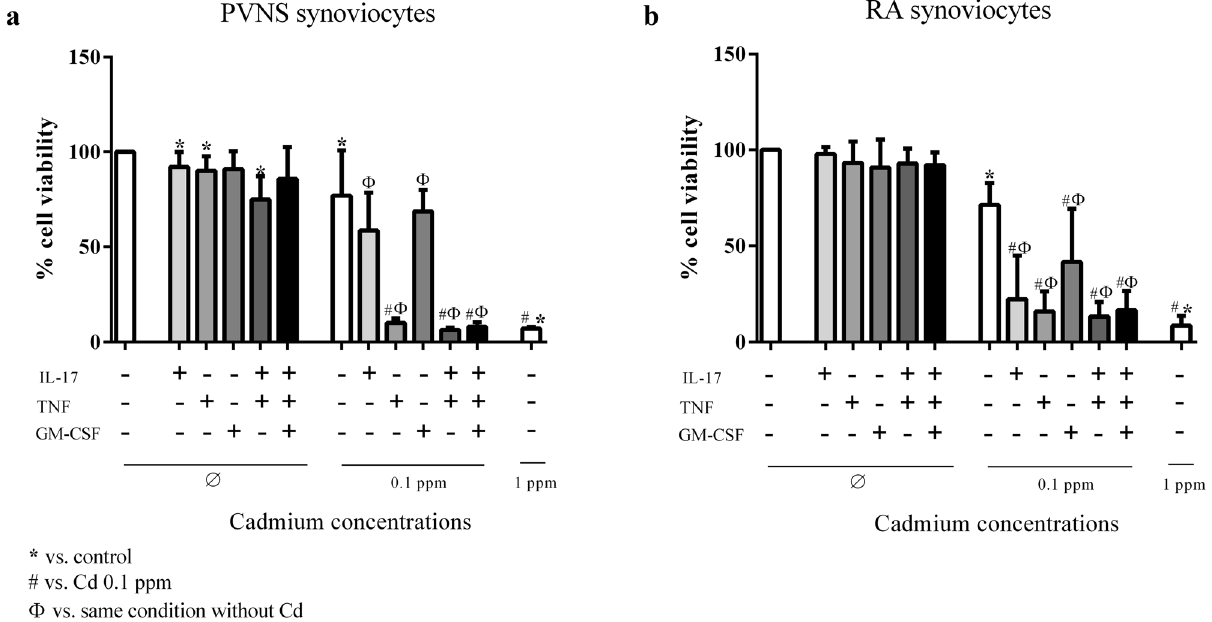
Figure 5. Quantification of cell viability of PVNS and RA synoviocytes 6 days after Cd exposure. PVNS ( a ) and RA ( b ) synoviocytes, used between passages 4 to 9, were treated or not with 0.01 ppm of Cd, in the presence or the absence of pro-inflammatory cytokines (IL-17: 50 ng/ml; TNF: 1 ng/ml; GM-CSF: 10 ng/ml). Cell viability was quantified by neutral red assay of PVNS ( a ) and RA ( b ) synoviocytes. Results are presented as mean ± SD, * p < 0.05. n = 6 from 3 PVNS patients and 3 RA patients.